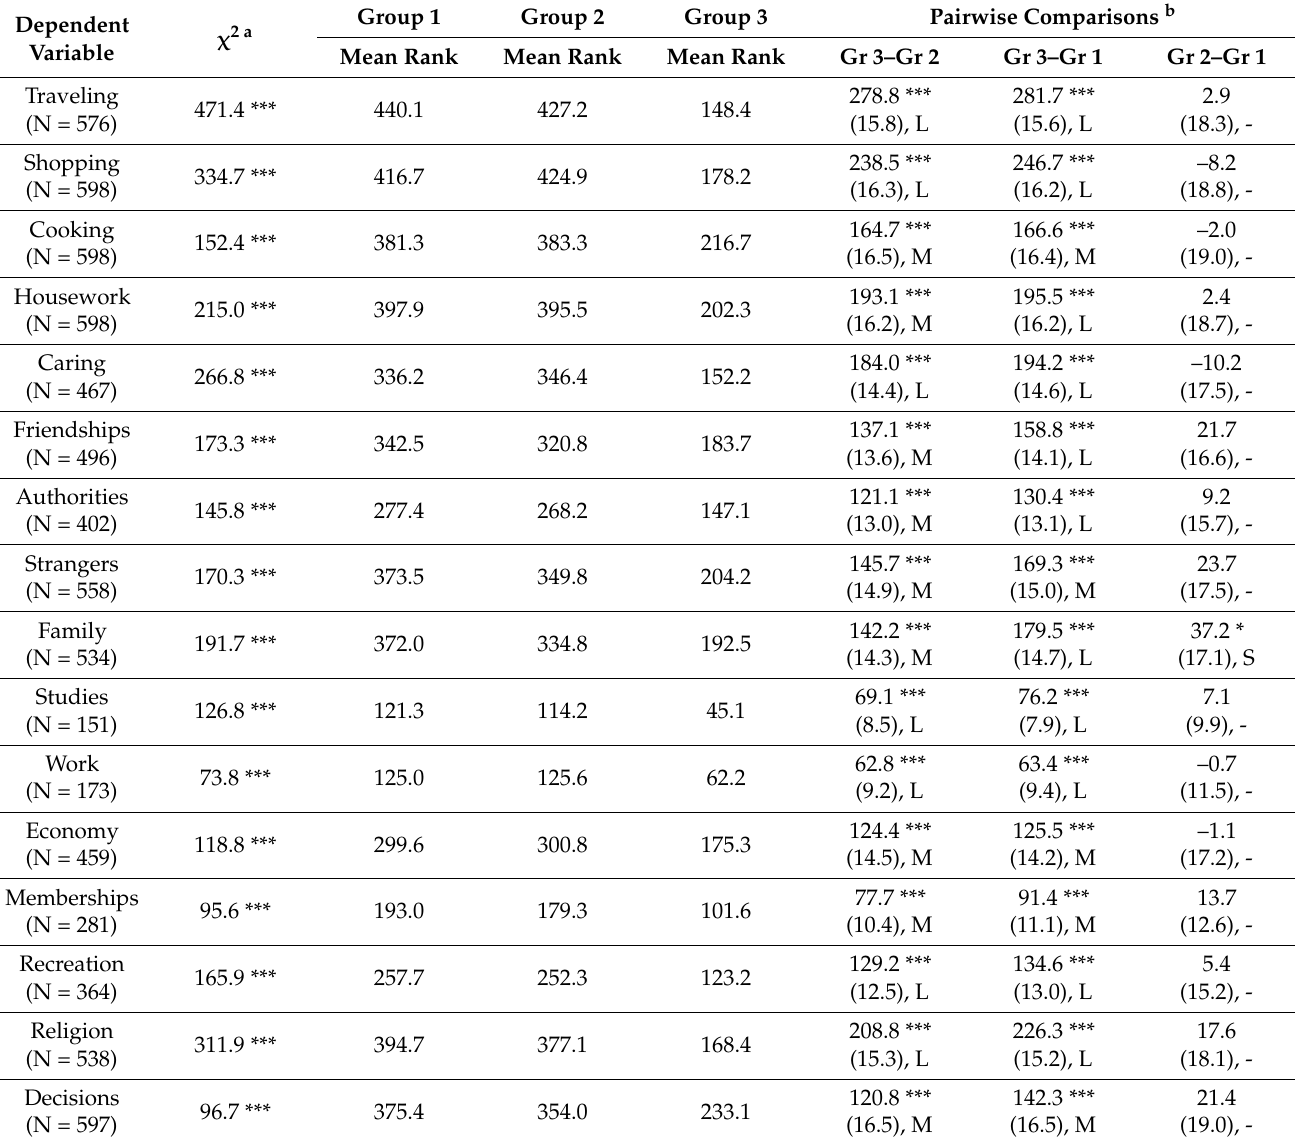
Table 4. Kruskal–Wallis and Bonferroni–Dunn post hoc test statistics for the data set on